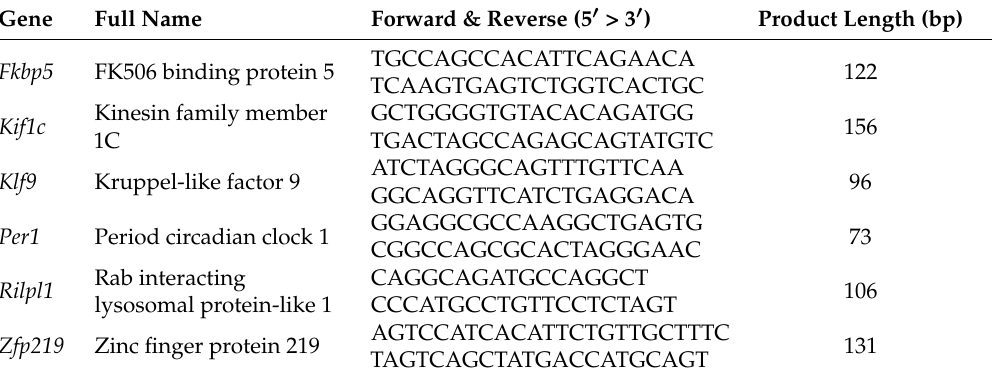
Table 1. Primer sequences used for qPCR on mouse hippocampal ChIP samples. Primers target a mineralocorticoid receptor binding site near the listed